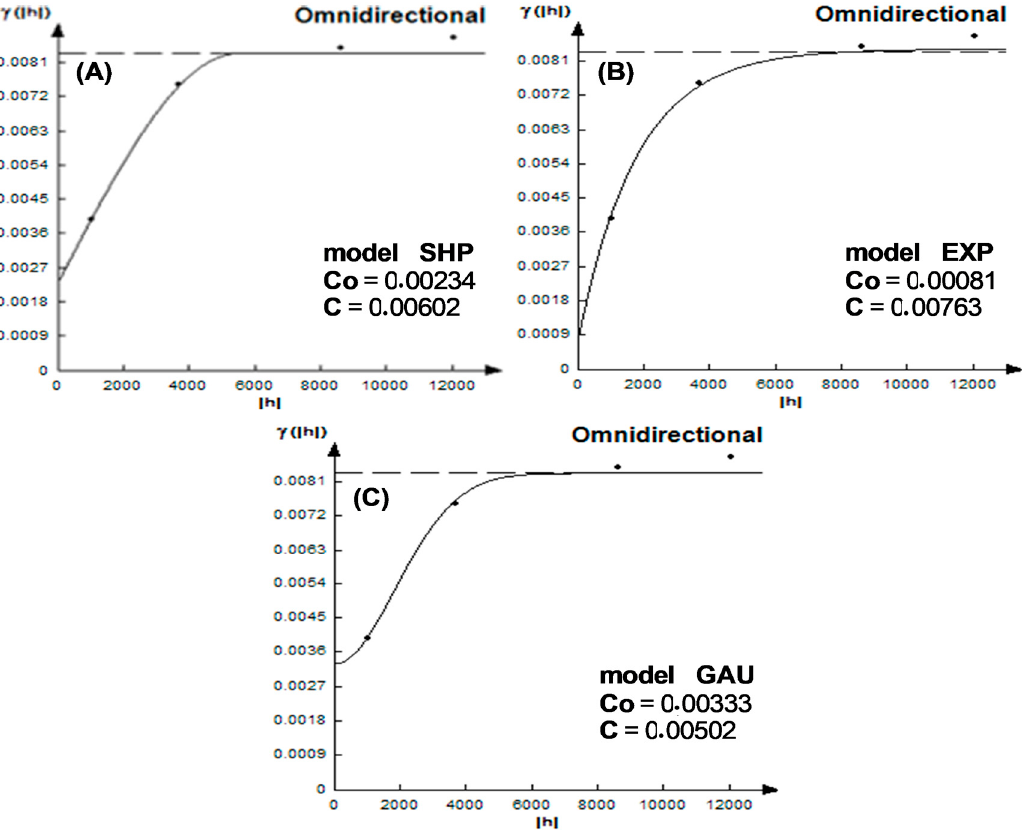
Figure A6. Adjustments via theoretical models to the omnidirectional variogram. ( A ): Co = 0.00234, C = 0.00602; ( B ): Co = 0.00081, C = 0.00763; ( C ): Co = 0.00333, C =